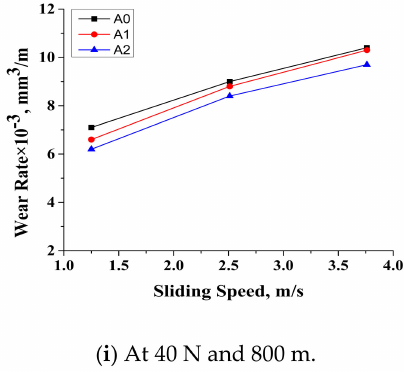
Figure 6. Wear rate vs.